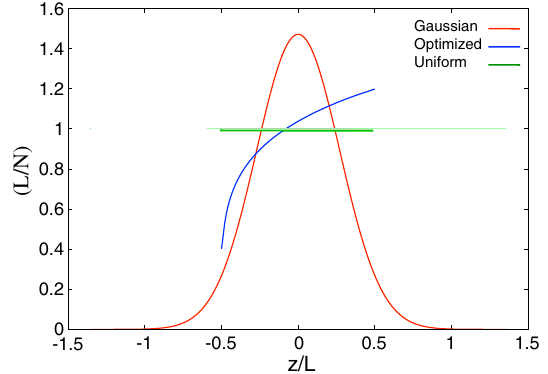
FIG. 10. Three initial current profiles used with the parameters shown in Table I for simulation in the chicane of Fig. 6.